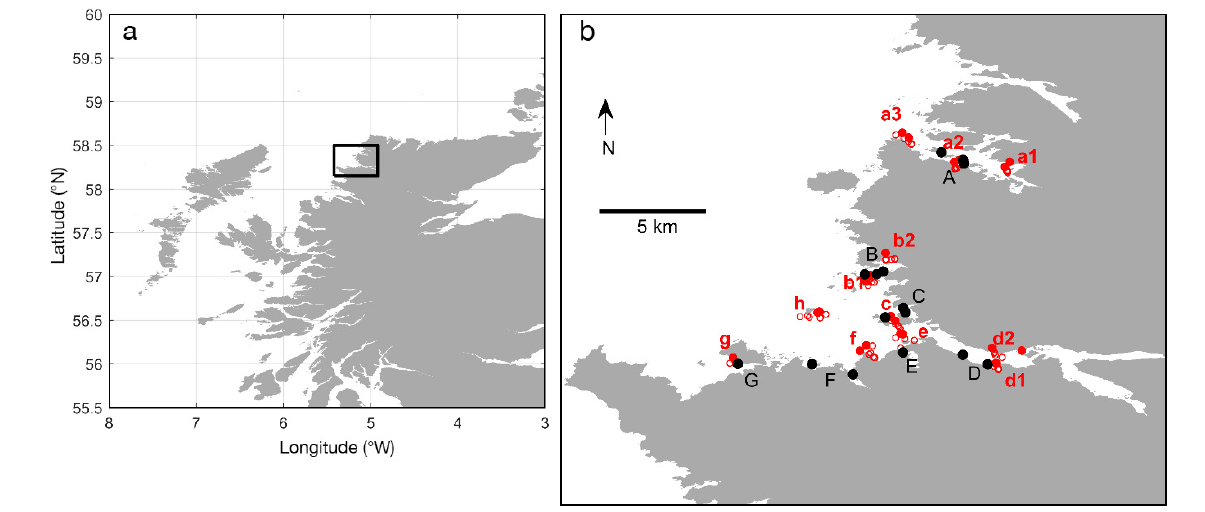
Fig. 1. (a) Focal study region in NW Scotland, UK. (b) Farm sites used for particle releases are indicated by black circles, black capital letters are site count groupings. Plankton trawls carried out during the simulated period are marked with solid red cir- cles, and those prior to the simulated period with open red disks. Sample station ID codes are given in small red